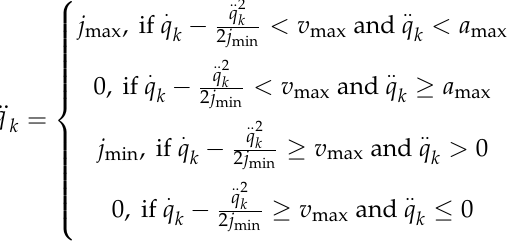
Figure 12. Typical profiles for position, velocity, acceleration, and jerk for the double S trajectory.